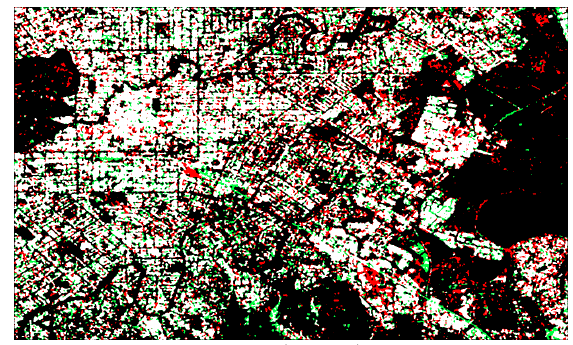
Figure 6. Comparison of the (average) coherence data before and after the